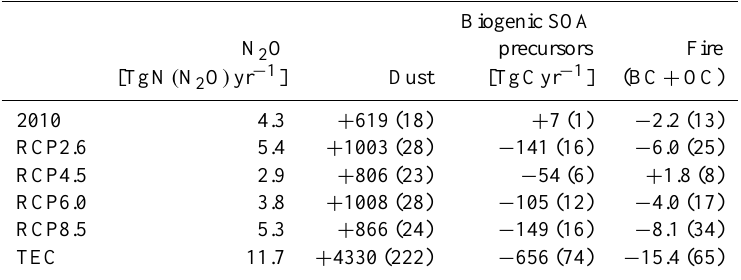
Table 1. Emissions of important aerosol and trace gases attributed to LULCC activities for year 2010 and year 2100 for the listed future scenarios (theoretical extreme case is abbreviated to TEC). Values are given in Tg(species)yr − 1 except where noted otherwise. Values in parentheses are the percentage change in global emissions attributed to LULCC for the year and scenario listed. Biogenic SOA precursors are considered the sum emissions of biogenic CO, isoprene, monoterpenes, and methanol. Biogenic